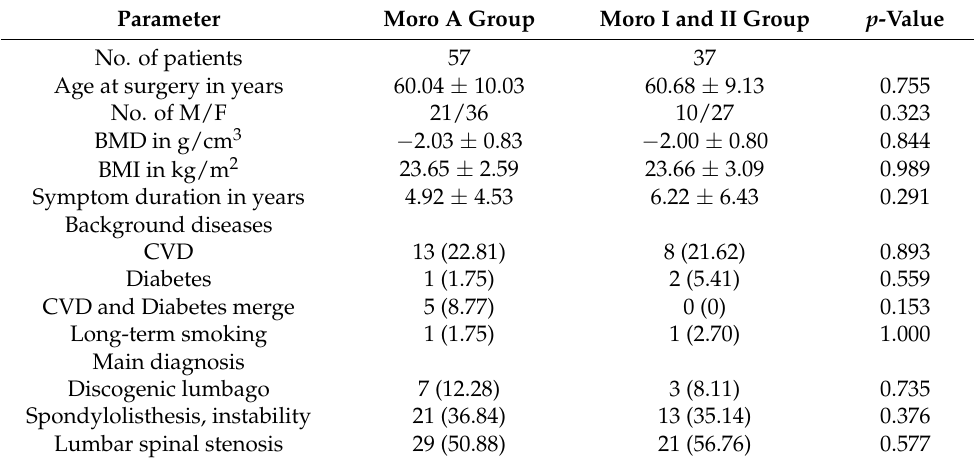
Table 1. Summary of patient demographics.